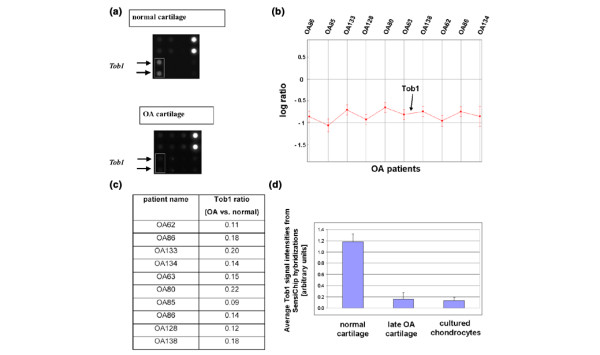
Tob1 expression in normal and osteoarthritic cartilage (oligonucleotide array experiments). (a) Area of one customized SensiChip microarray illustrating the 70-mer oligonucleotide spots that represent the 3'-untranslated region of human Tob1 and demonstrate its differential expression between normal and one late-stage osteoarthritic cartilage. (b) Trend plot demonstrating the transcriptional downregulation of human Tob1 in all RNA samples from cartilage of late-stage osteoarthritis patients used for SensiChip hybridization experiments. The logarithmic ratio of differential Tob1 expression calculated by the software Resolver is plotted against the corresponding osteoarthritic patient sample used for expression profiling. Error bars indicate standard deviations of ratios. P values for the ratios of all 10 osteoarthritic samples were less than 0.05. (c) Transcriptional downregulation of human Tob1 in late-stage osteoarthritic cartilage samples from 10 human donors. All Tob1 ratios were calculated by the gene expression analysis software Resolver. P values for the ratios of all 10 osteoarthritic samples were less than 0.05. (d) Plot of average Tob1 signal intensities from independent SensiChip microarray hybridizations using RNA samples from normal cartilage, late-stage osteoarthritic cartilage and cultured primary human chondrocytes. Tob1 signal intensities from independent SensiChip hybridizations of RNA samples from pooled normal cartilage (10 hybridization experiments), 10 late-stage osteoarthritis patients (10 hybridization experiments) and 5 different cell culture samples of proliferating primary human chondrocytes (5 hybridization experiments) were merged respectively and are plotted as average Tob1 signal intensities. Error bars indicate standard deviations of Tob1 signal intensities.